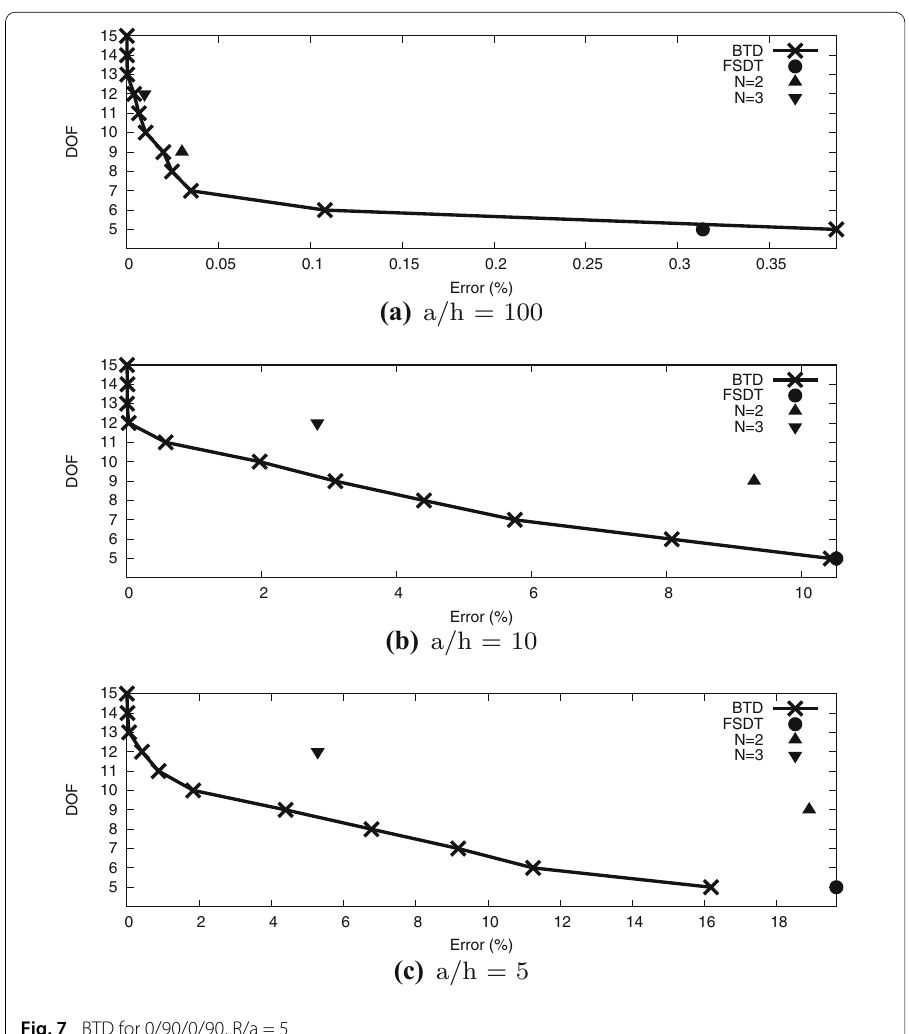
Fig. 7 BTD for 0/90/0/90, R/a =